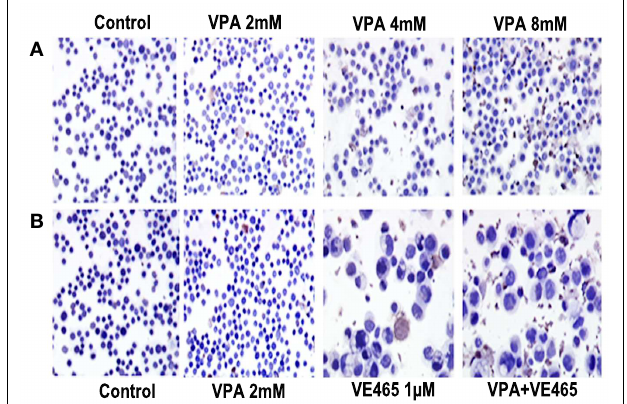
FIGURE (cid:1) 5 (cid:1) | (cid:1) TUNEL (cid:1) analysis (cid:1) of (cid:1) apoptosis (cid:1) induced (cid:1) by (cid:1) 72 (cid:1) h (cid:1) of (cid:1) treatment (cid:1) with (cid:1) VPA (cid:1) alone (cid:1) and (cid:1) in (cid:1) combination (cid:1) with (cid:1) VE465 (cid:1) in (cid:1) 2008/C13 (cid:1) cells. (cid:1) (A) (cid:1) Treatment (cid:1) with (cid:1) VPA (cid:1) alone (cid:1) at (cid:1) increasing (cid:1) concentrations (cid:1) of (cid:1) 2–8 (cid:1) mM. (cid:1) (B) (cid:1) Co-treatment (cid:1) with (cid:1) VPA (cid:1) (2 (cid:1) mM) (cid:1) and (cid:1) VE465 (cid:1) (1 (cid:1) µ M). The experiments presented in (A,B) were carried out at the same time and the control presented in both panels was the same.